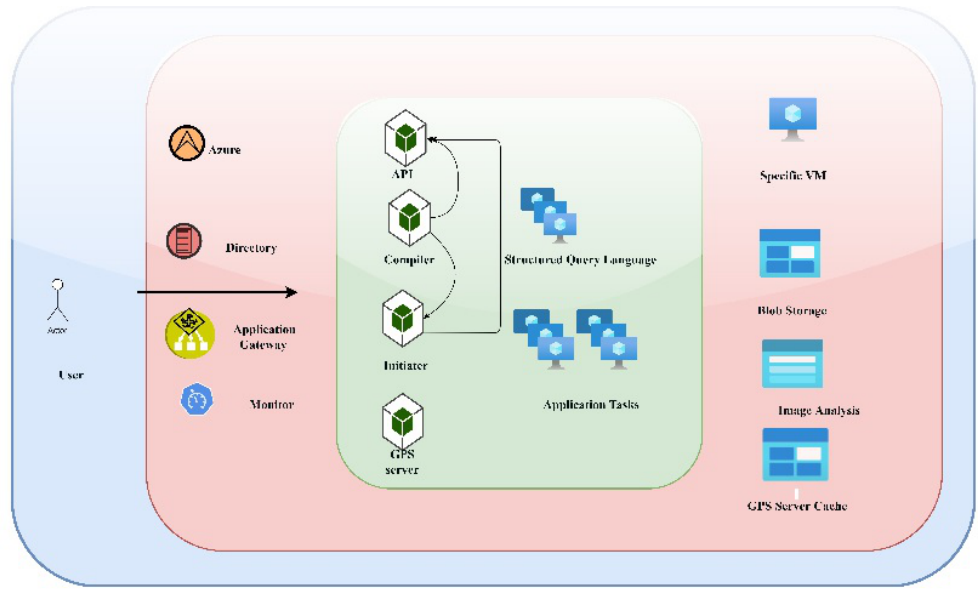
Figure 8. Microsoft Azure computing: generic